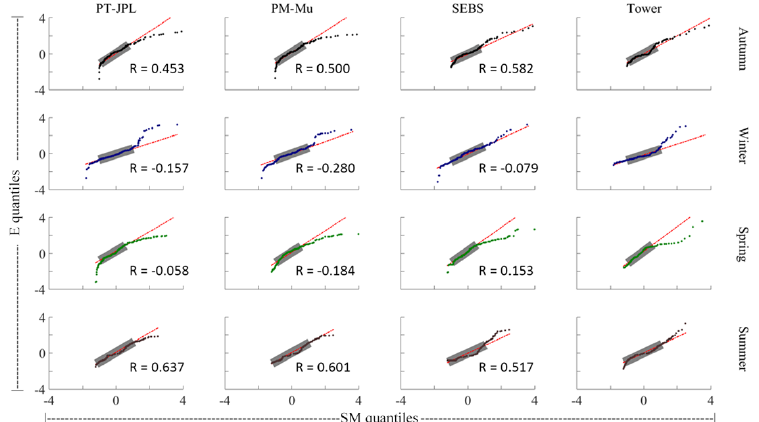
Figure 8. Q–Q plots of standardized soil moisture vs. standardized evaporation for each season. R values denote Pearson’s correlation between standardized soil moisture and modelled evaporation for that particular